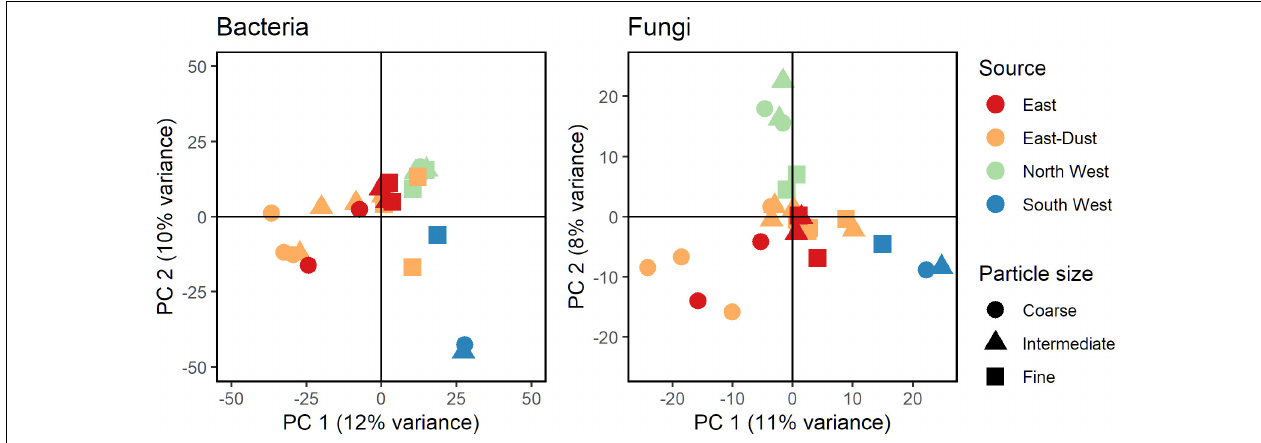
FIGURE 1 | Principal Component Analysis (PCA) analysis of bacterial (Left) and fungal (Right) communities. Based on Euclidean distances of clr-transformed ASV